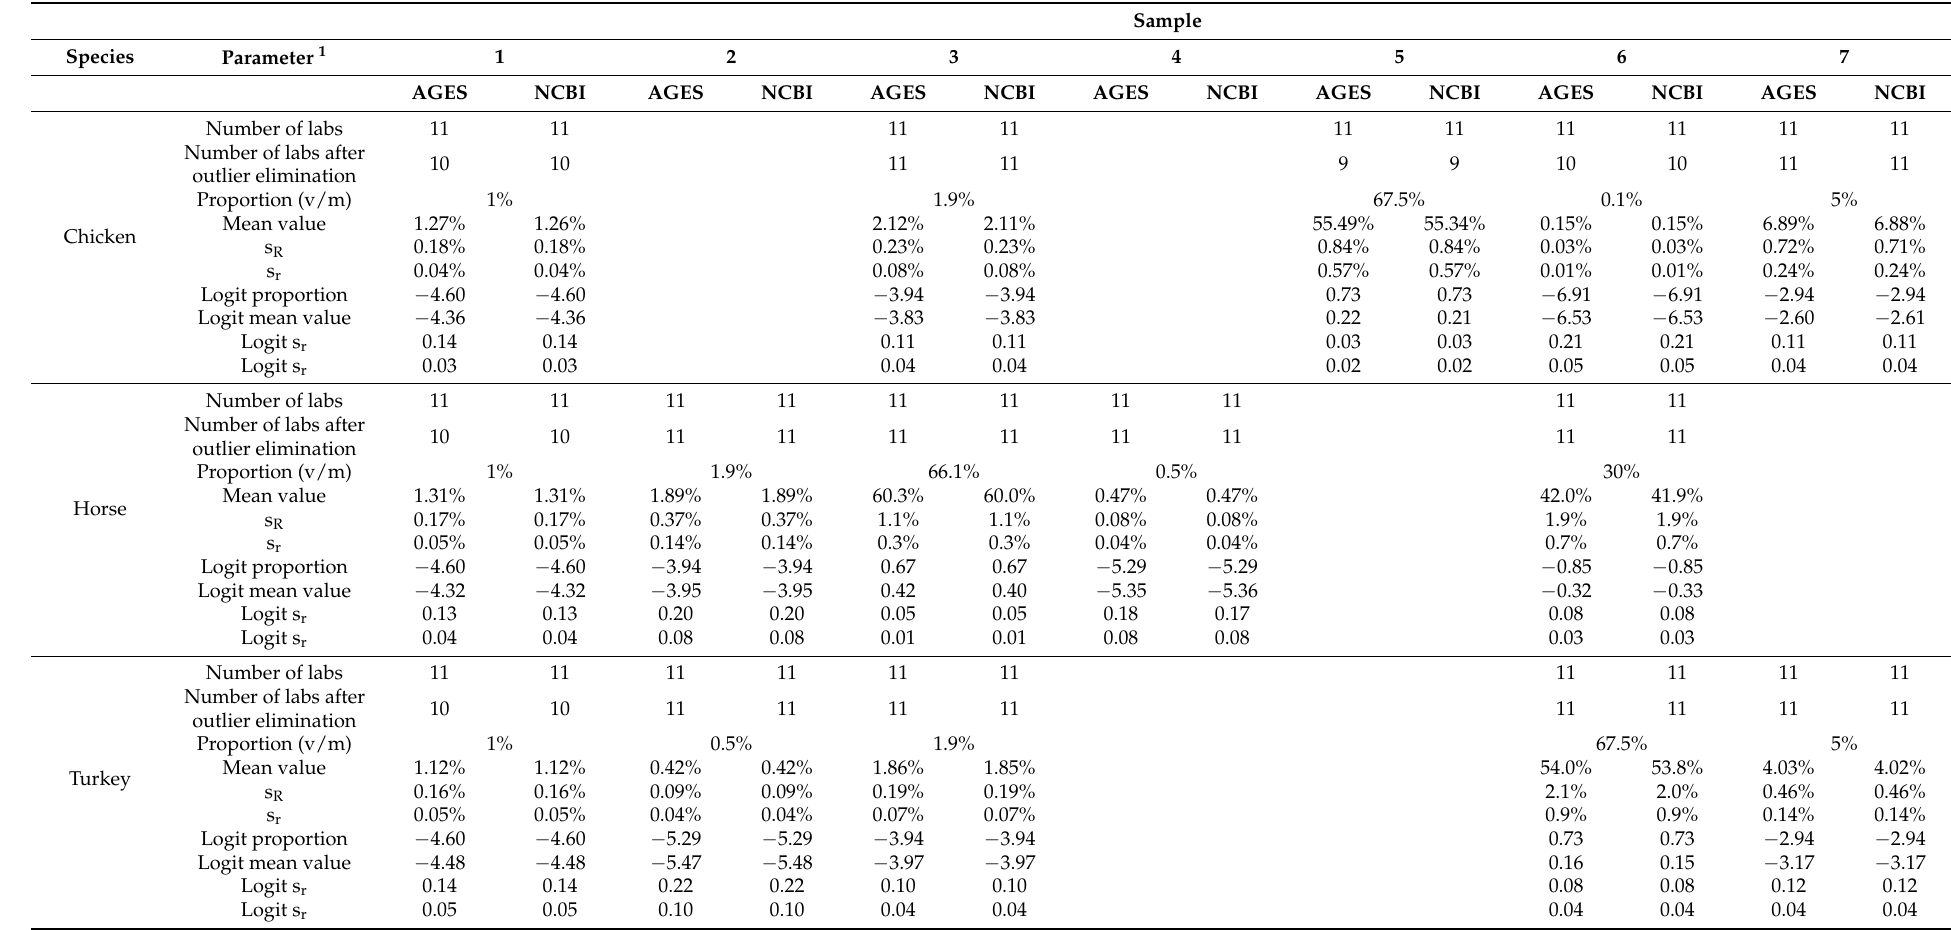
Table 4. Statistical parameters for relative proportions of animal species according to ASU §64 LFGB. AGES: AGES database, NCBI: NCBI database.